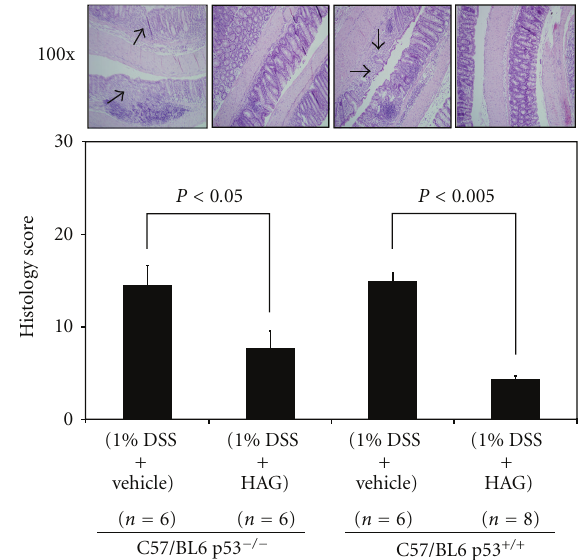
Figure 3: E ff ect of the HAG on the colon histology score of the acute DSS colitis model. Histological Inflammation score was determined from the H&E stained colon of each group of mice treated with HAG after 2.5 cycles of DSS. Values represent mean ± S.E. Representative H&E stained colon (100x magnified) is shown for each group. Arrows point to areas of inflammation and ulceration. Significant di ff erences are